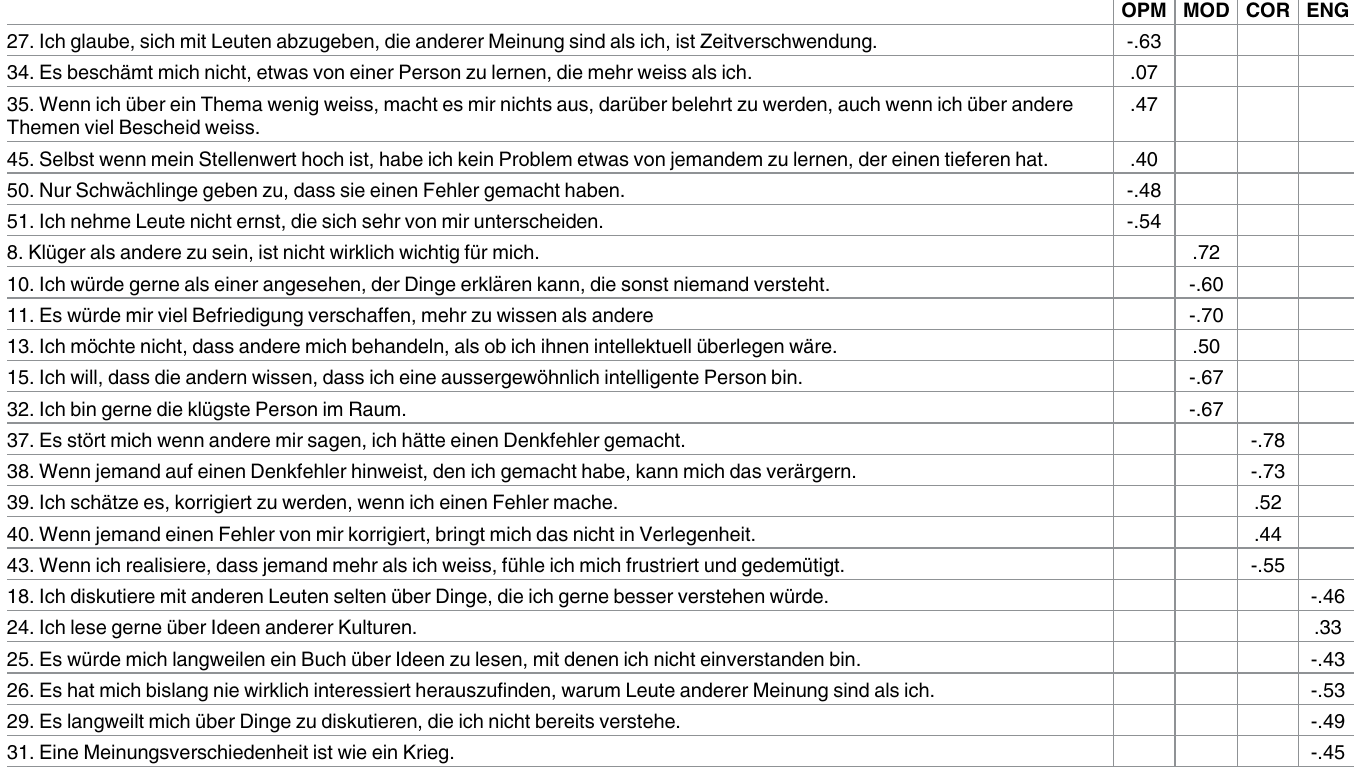
Table 12. The 4-factor solution (German